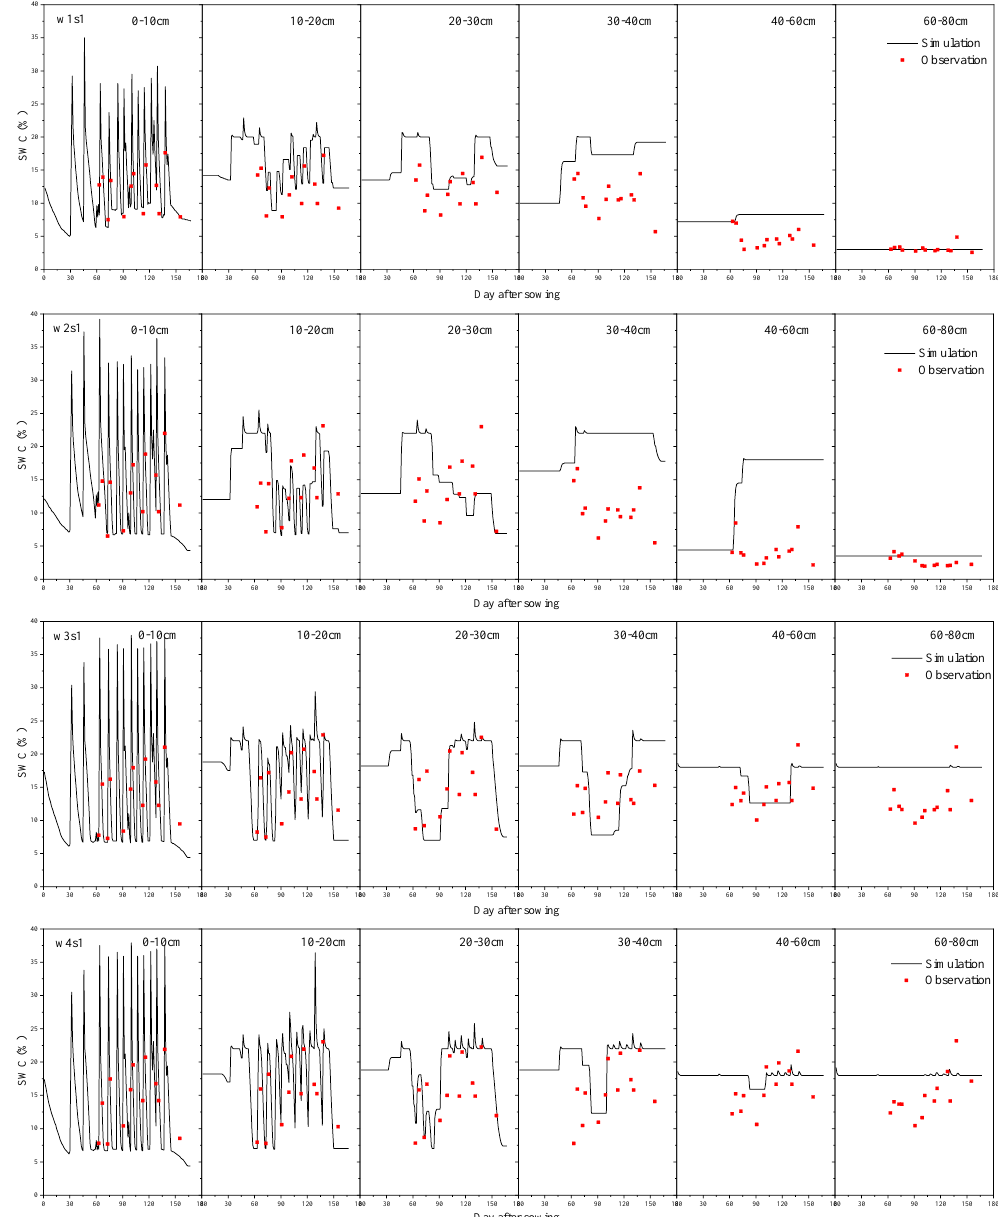
22.5, 30, 37.5 and 45 mm. S1, S2 and S3 represent the soil salinity of 0.2%, 0.4% and 0.6%.)